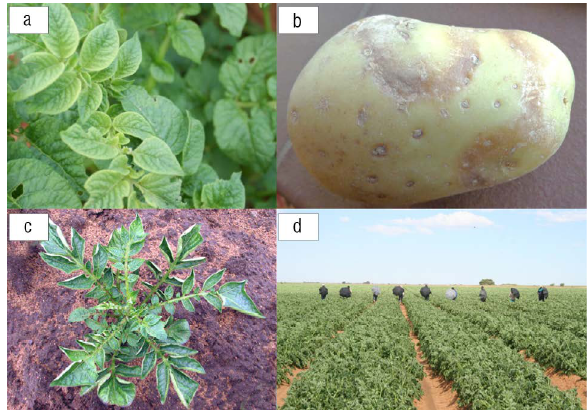
(a) Potato leaflets with mosaic (chlorotic patches) symptoms of Potato virus Y (PVY). (b) Potato tuber with necrotic lesions caused by PVY NTN infection (photo: Potato Certification Service, South Africa). (c) Foliar symptoms of Potato leafroll virus (photo: Diedrich Visser, Agricultural Research Council – Vegetable and Ornamental Plants). (d) Roguing of